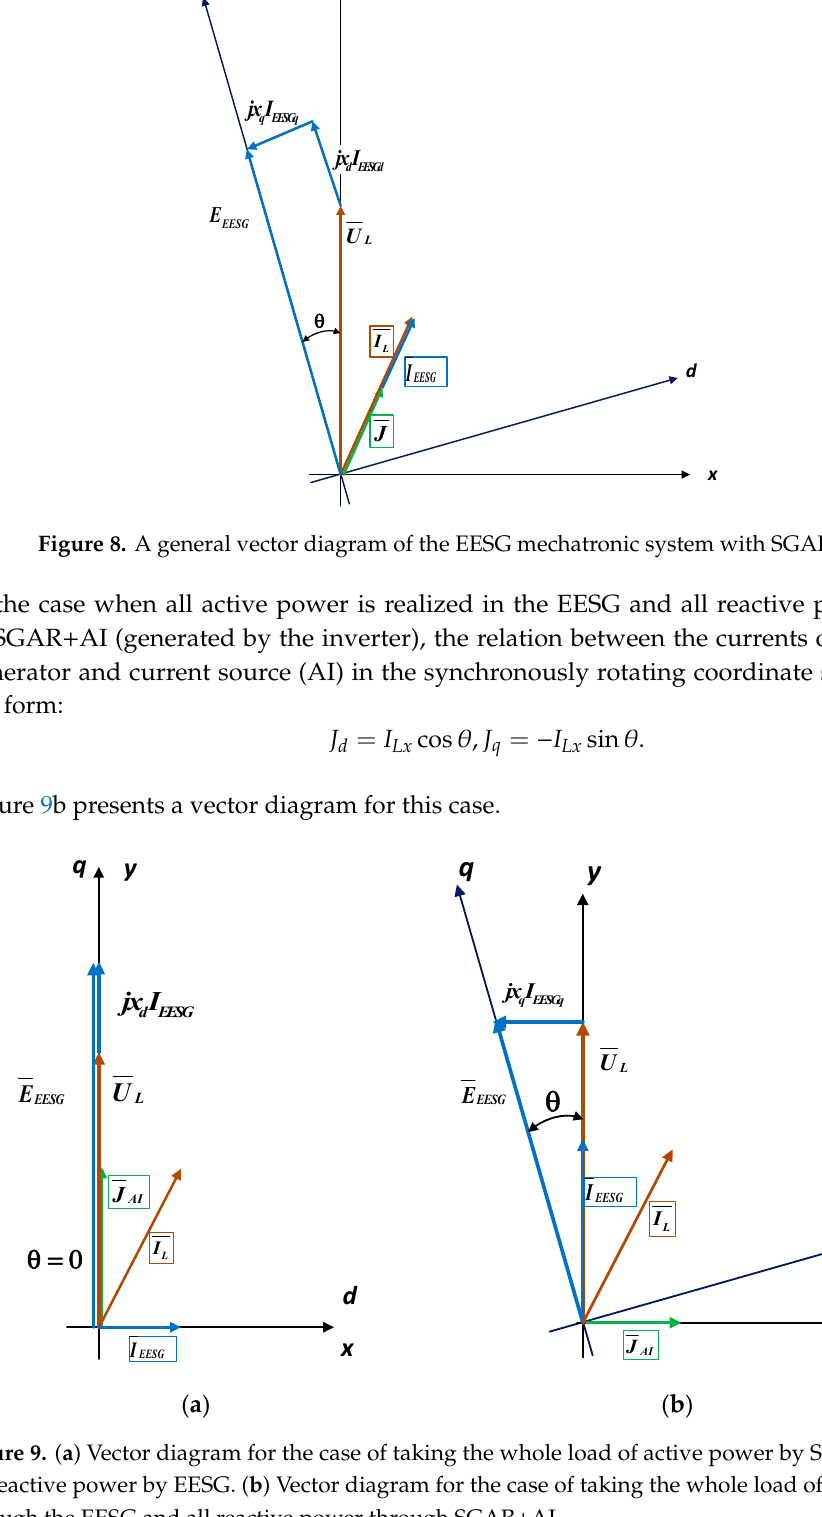
Figure 9. ( a ) Vector diagram for the case of taking the whole load of active power by SGAR+AI and all reactive power by EESG. ( b ) Vector diagram for the case of taking the whole load of active power through the EESG and all reactive power through SGAR+AI.